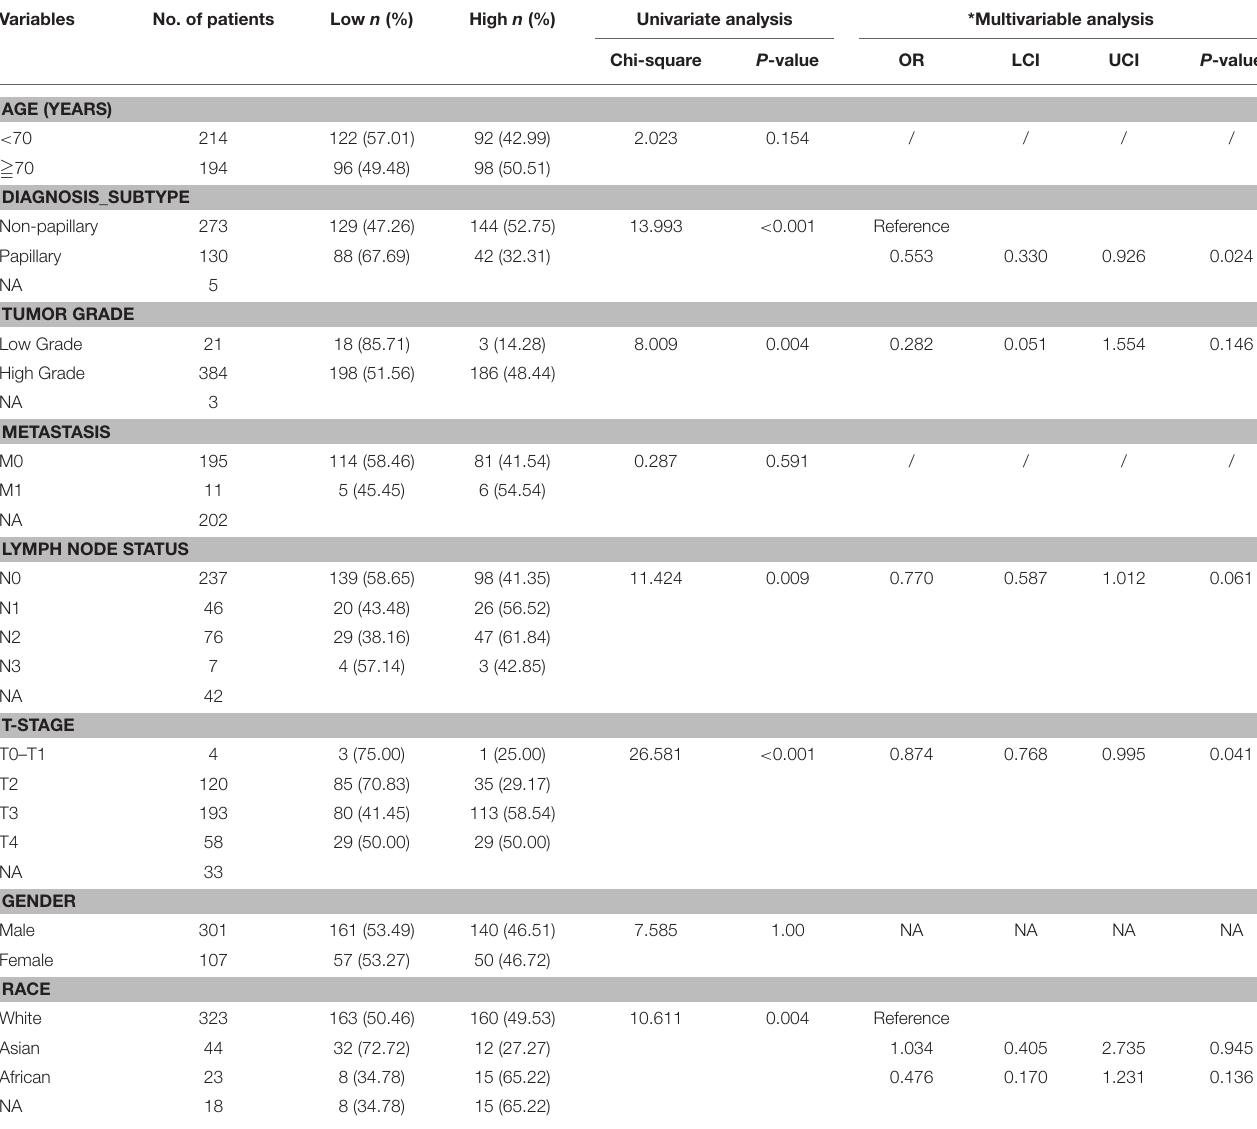
TABLE 2 | Correlation between the 21-miRNA signature and patients’ clinicopathological features.